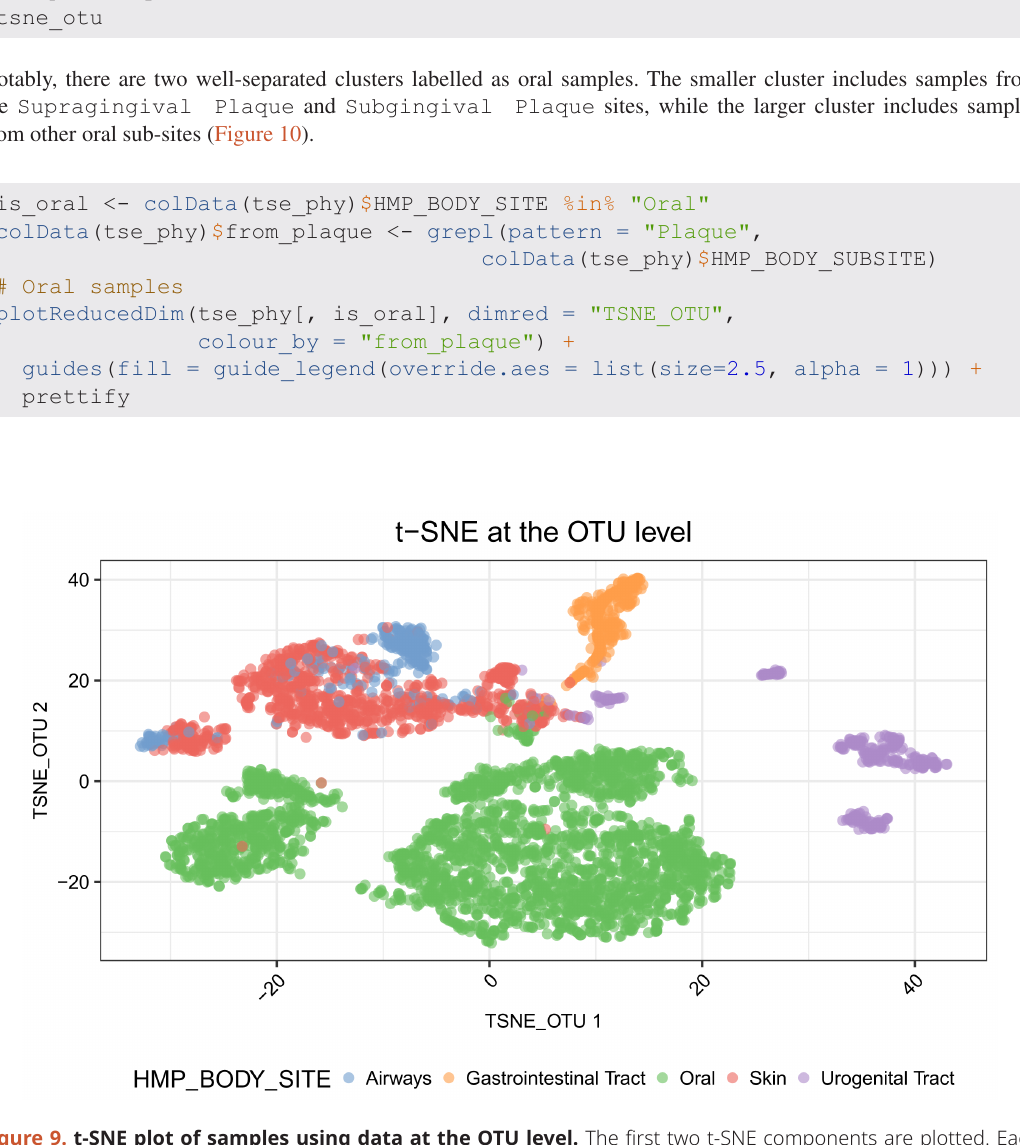
Figure 9. t-SNE plot of samples using data at the OTU level. The first two t-SNE components are plotted. Each point represents a sample. Samples are coloured according to the body site.